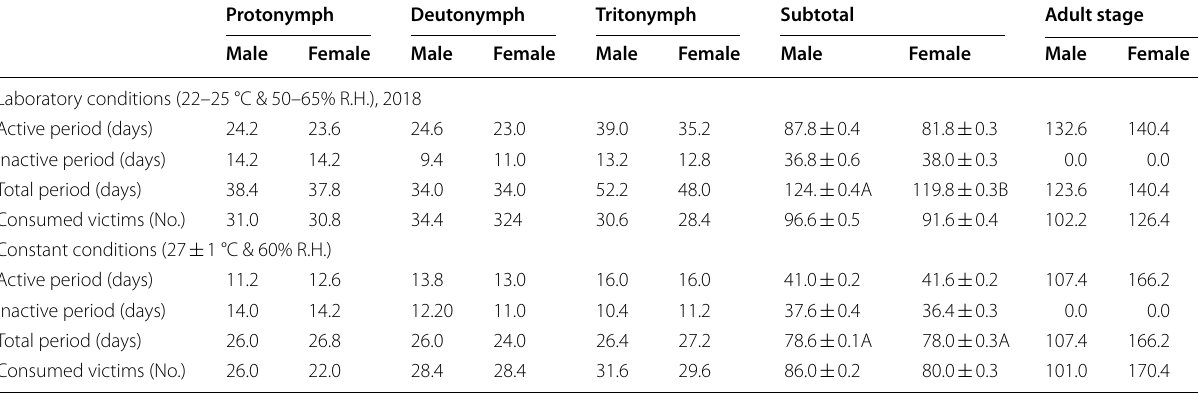
*Means based on 15 individually reared animals per rearing conditions Means within a row with the same letter are not significantly different (t test, P >